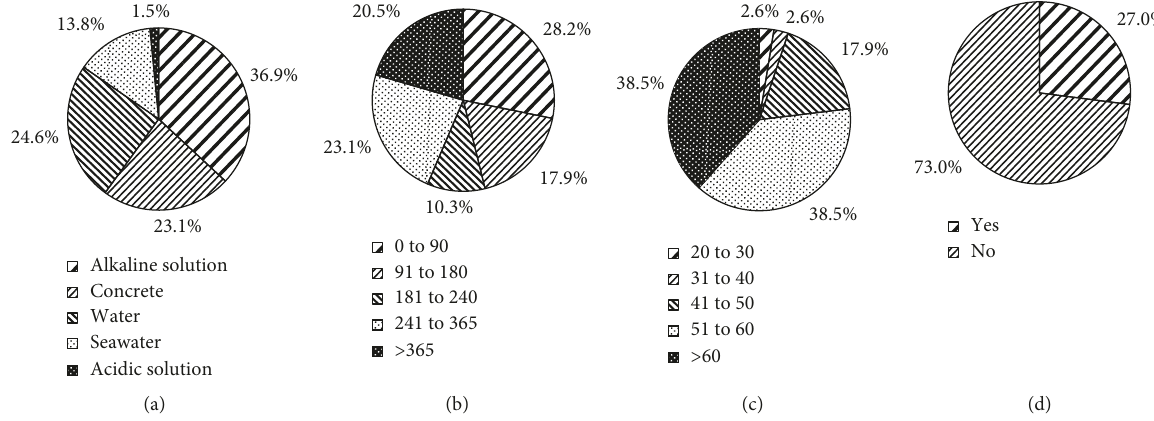
Figure 6: Percentage distribution of conditioning parameters. (a) Surrounding media. (b) Maximum conditioning duration (days). (c) Maximum conditioning temperature ( ° C). (d) Presence of sustained